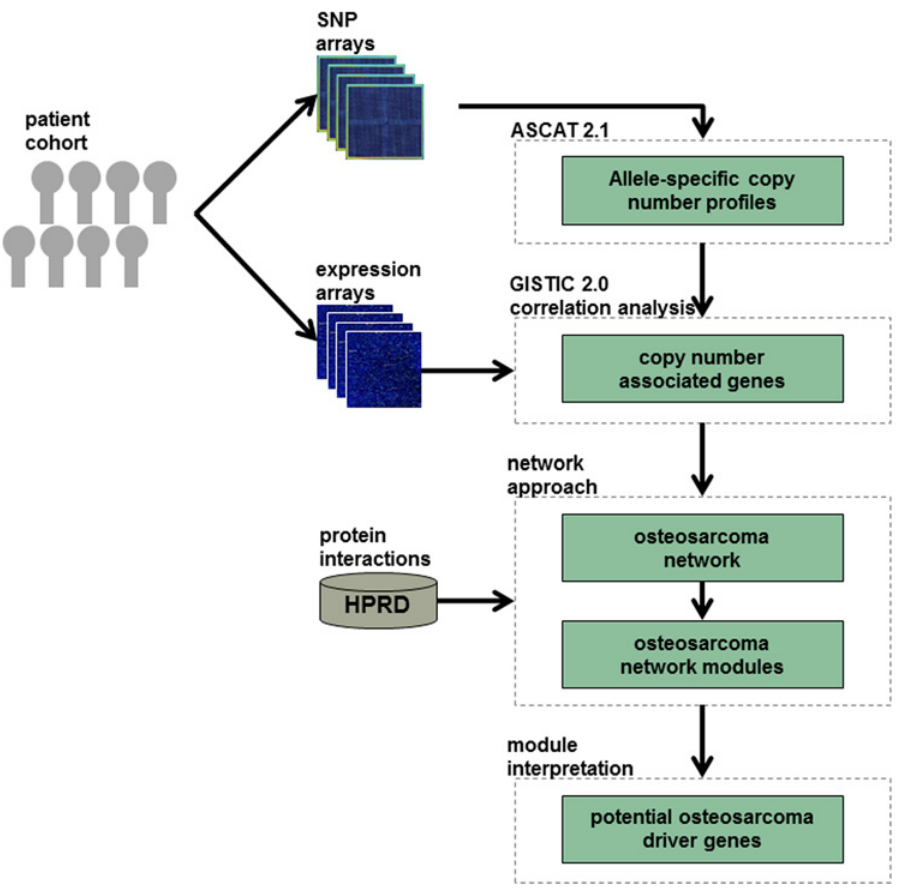
Fig 1. Analysis workflow. The figure gives an outline of the analysis performed in the current